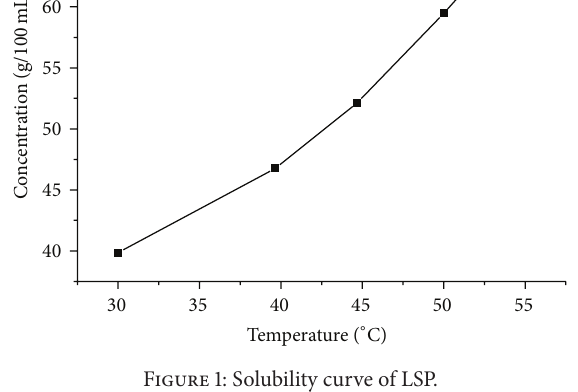
Figure 1: Solubility curve of LSP.